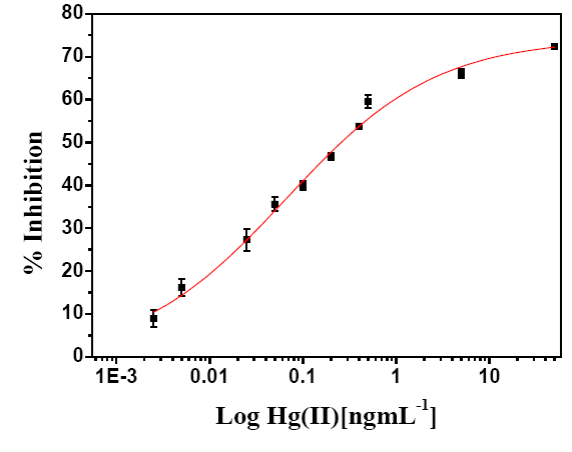
Figure 4. Calibration curve for Hg (II). Percentage of inhibition (% I) versus logarithm of Hg(II) concentration in ng . mL −1 is presented. The error bar indicates standard deviation (n = 3, where n is an independent assay by proposed method). Degree of inhibition of free AlOx (0.01 U) using 0.5 mM methanol for 20 min incubation time using 0.1 M PB, pH 7.5 at 35 ° C. Equation for line is Y = 20.77X + 62.53.